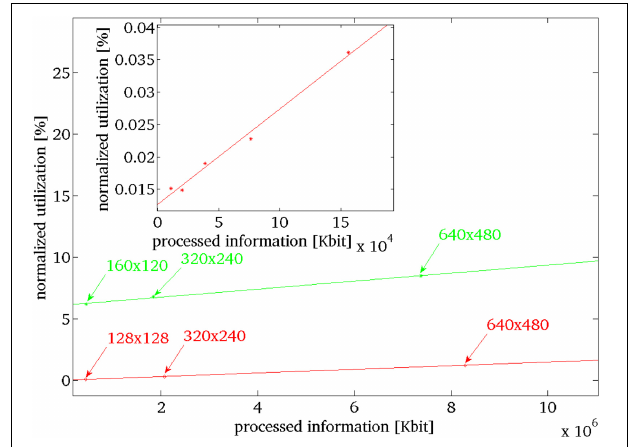
FIGURE 5 | Expected evolution of the normalized computation demand for increasing the sensor’s output by increasing the sensor’s size, in green iNVT and in red EVA. In the inset the measured data for EVA, for increasing number of events, generated by increasing number of black rotating edges repeated, respectively, at 360 ◦ , 180 ◦ , 90 ◦ , 45 ◦ , and 22.5 ◦ , in red the fit from which we extrapolate the computational demand for bigger sensors.